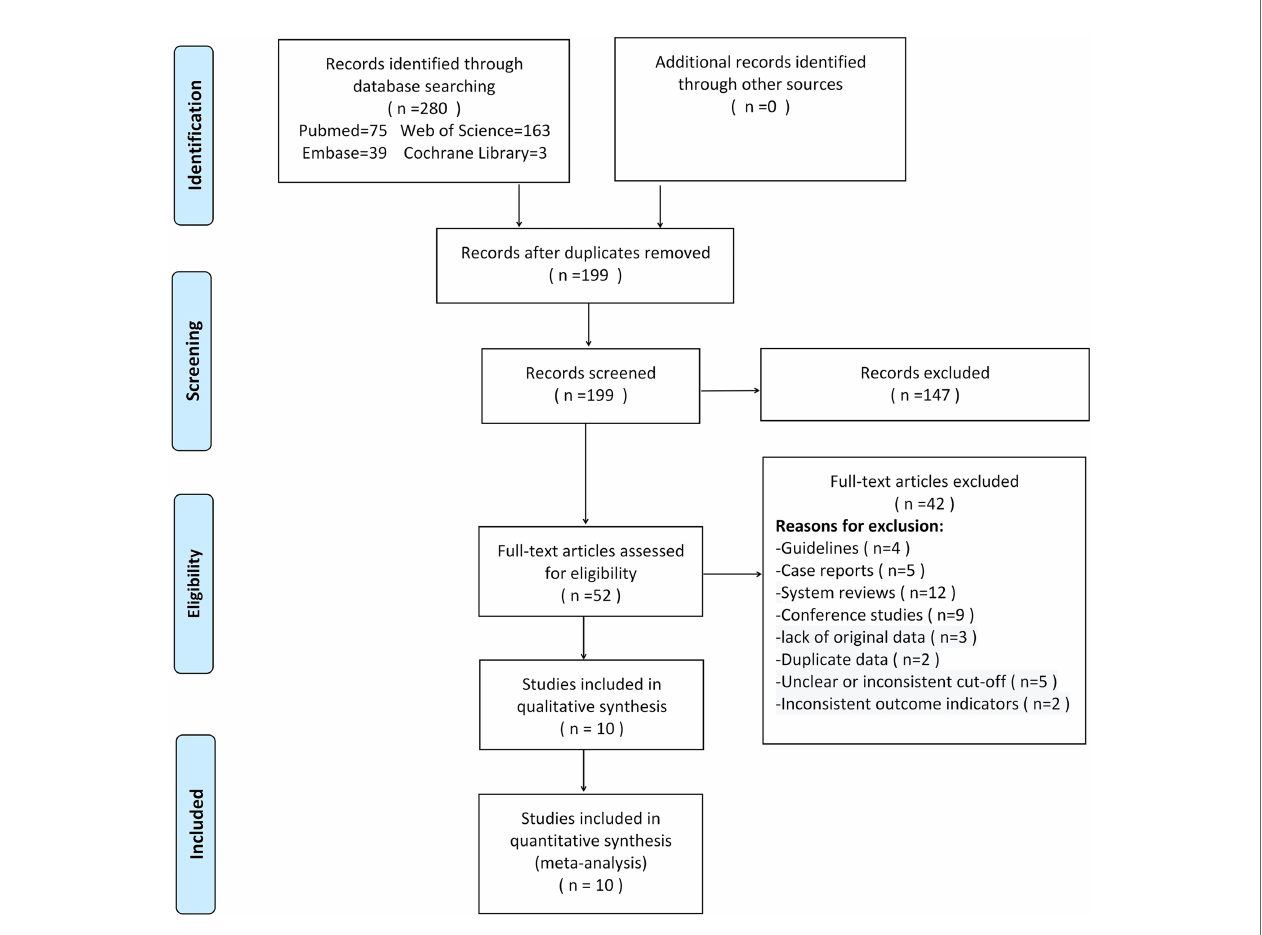
FIGURE 1 | Flow chart of selection process.